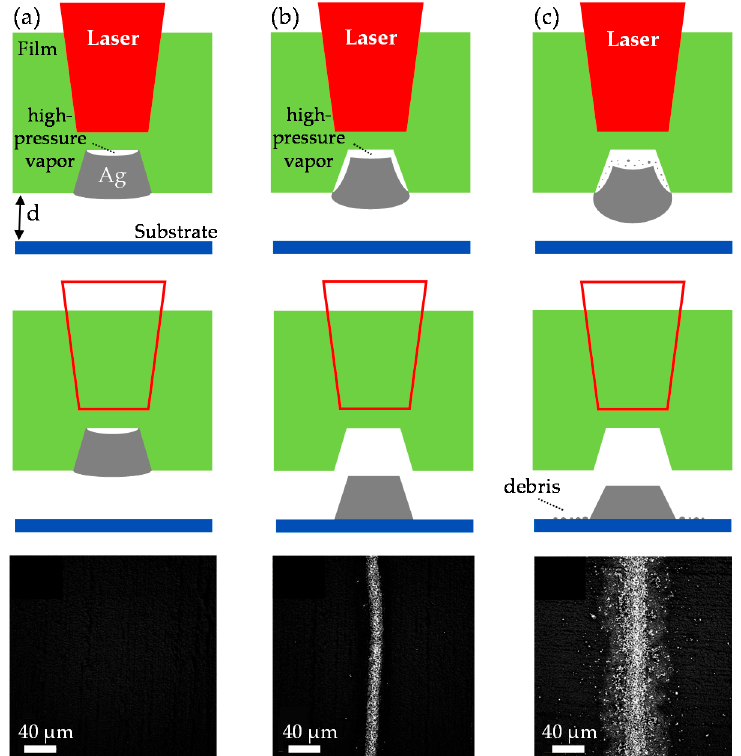
Figure 2. Schematic of paste transfer during the PTP laser transfer process for different laser power: ( a ) no transfer, when the operating laser is below the laser power threshold; ( b ) optimum transfer, for laser power slightly above the threshold; ( c ) explosive transfer, when the laser power is significantly above the laser power threshold.